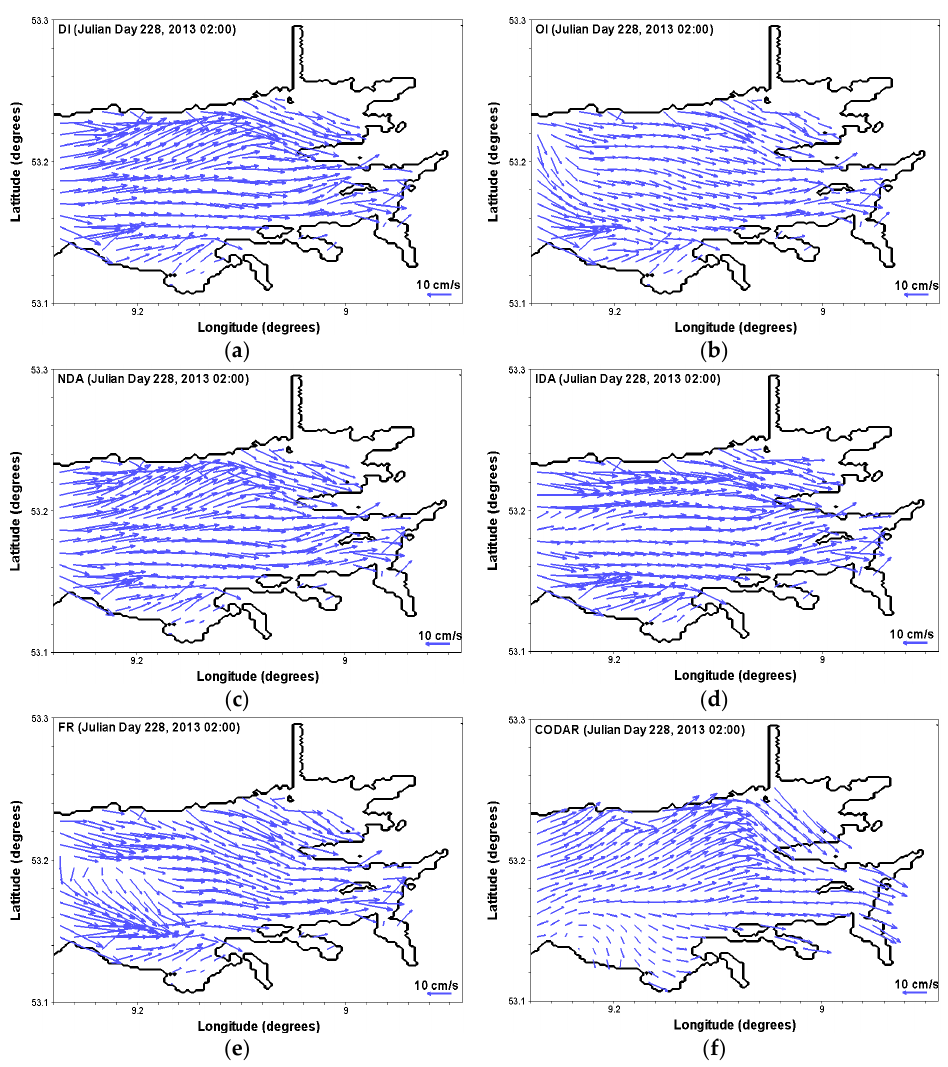
Figure 5. Vector fields of surface currents at Julian Day 228 02:00: ( a – d ) model DI, OI, NDA and IDA, respectively; ( e ) model FR; and ( f ) HFR data.